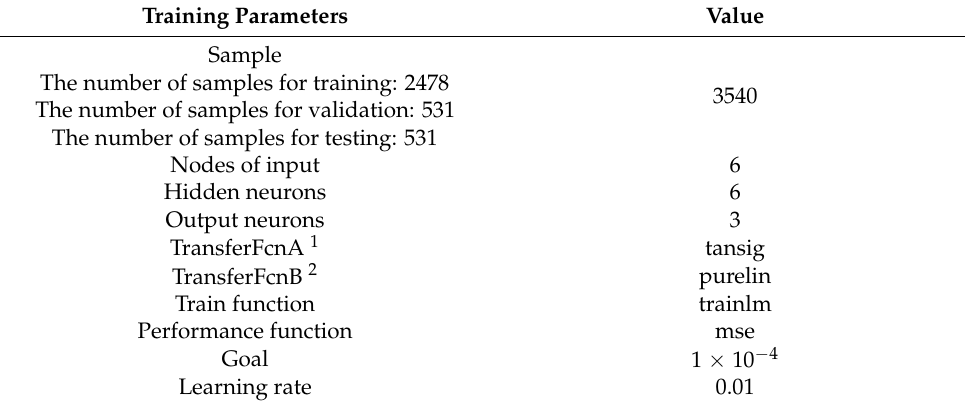
Table 2. Parameters for back propagation neural network (BPNN) model training.